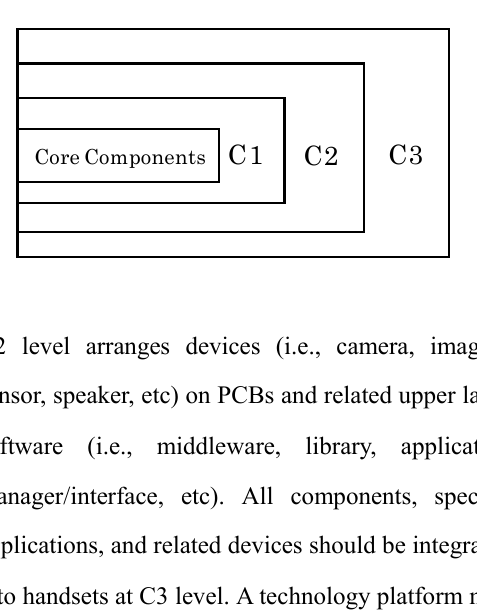
Figure 2 . A system of nested